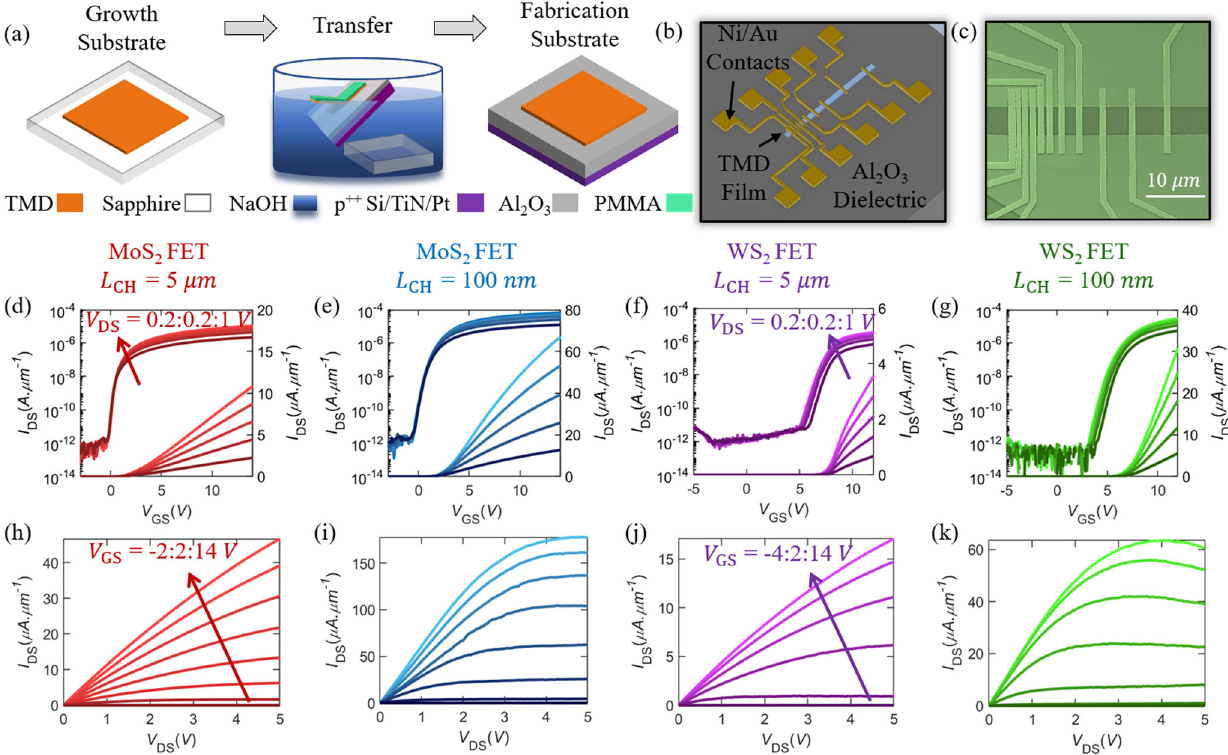
Fig. 2 Device fabrication and electrical measurements. a Schematic representation of PMMA-assisted wet transfer of monolayer TMD fi lms from sapphire (growth substrate) to an Al 2 O 3 substrate. b Schematic representation and c SEM of a TLM structure de fi ned using e-beam lithography. TLM structures with channel length ( L CH ) from 100 nm to 5 μ m are fabricated and the channel width is de fi ned to be 5 μ m. Transfer characteristics, i.e., drain current ( I DS ) versus gate voltage ( V GS ), for different drain voltages ( V DS ) in logarithmic and linear scale for d longest-channel ( L CH = 5 μ m) and e shortest- channel ( L CH = 100 nm) MoS 2 fi eld-effect transistors (FETs), and f longest-channel ( L CH = 5 μ m) and g shortest-channel ( L CH = 100 nm) WS 2 FETs. Corresponding output characteristics, i.e., I DS versus V DS , for different V GS for h longest-channel and i shortest-channel MoS 2 FETs, and j longest-channel and k shortest-channel WS 2